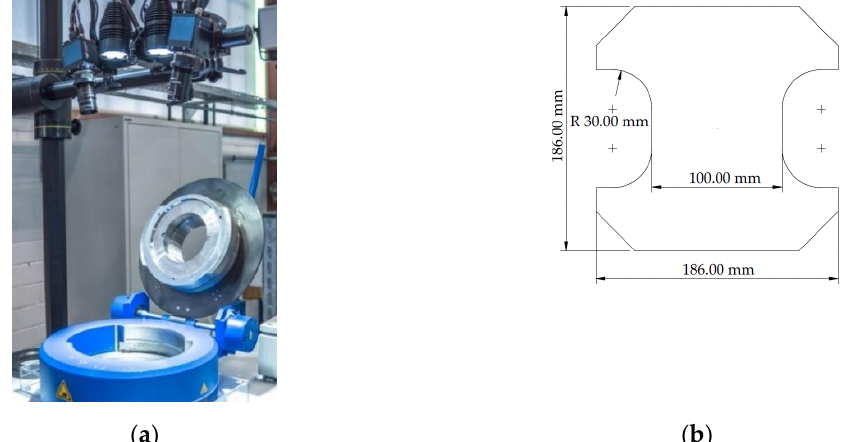
Figure 1. ( a ) Test setup for bulge test, Nakajima test and validation experiments ( b ) geometry of waisted Nakajima specimen exemplary with a remaining width of 100 mm.